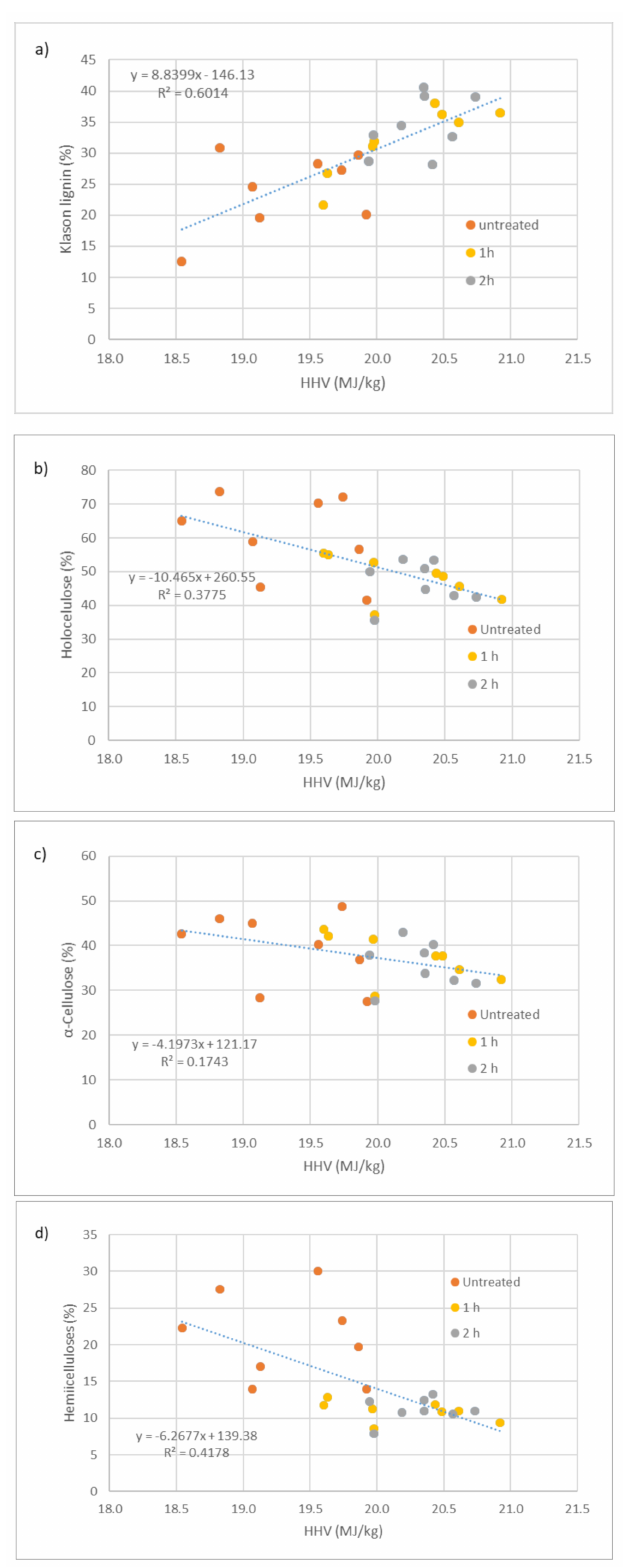
Figure 1. Variation of HHV with structural compounds of untreated and heat-treated woods: ( a ) Variation of HHV with Klason lignin; ( b ) with holocellulose; ( c ) with α -cellulose. ( d ) with